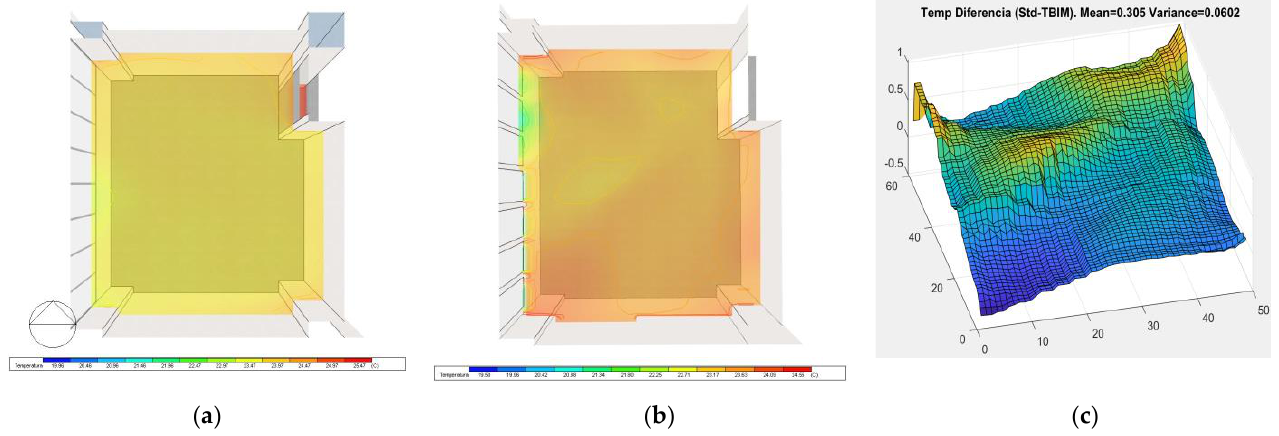
Figure 17. Temperature value 2D graph maps on a horizontal plane at Z = 1.50 m, obtained by CFD simulation of air flows, according to the condition of Room W1, at 17 h, on 19NovemberTMY 2007 – 2021: ( a ) Temperatures with the as-is STD Model, ( b ) Temperatures with the as-is T-BIM Model, and ( c ) Point-to-point resolution of temperature differences between both models that were compared.